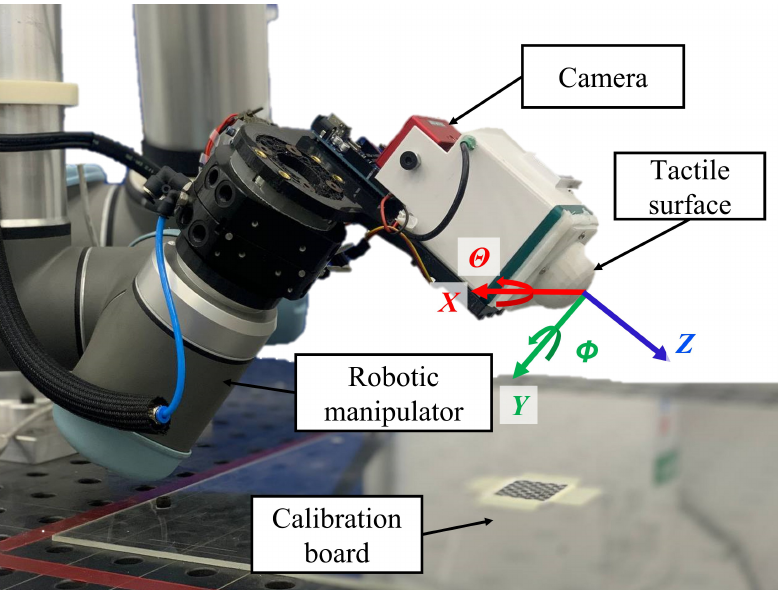
Figure 6. The experimental setup with the tactile sensor mounted on UR10 robotic manipulator showing the tactile surface frame that is precisely calibrated with the calibration